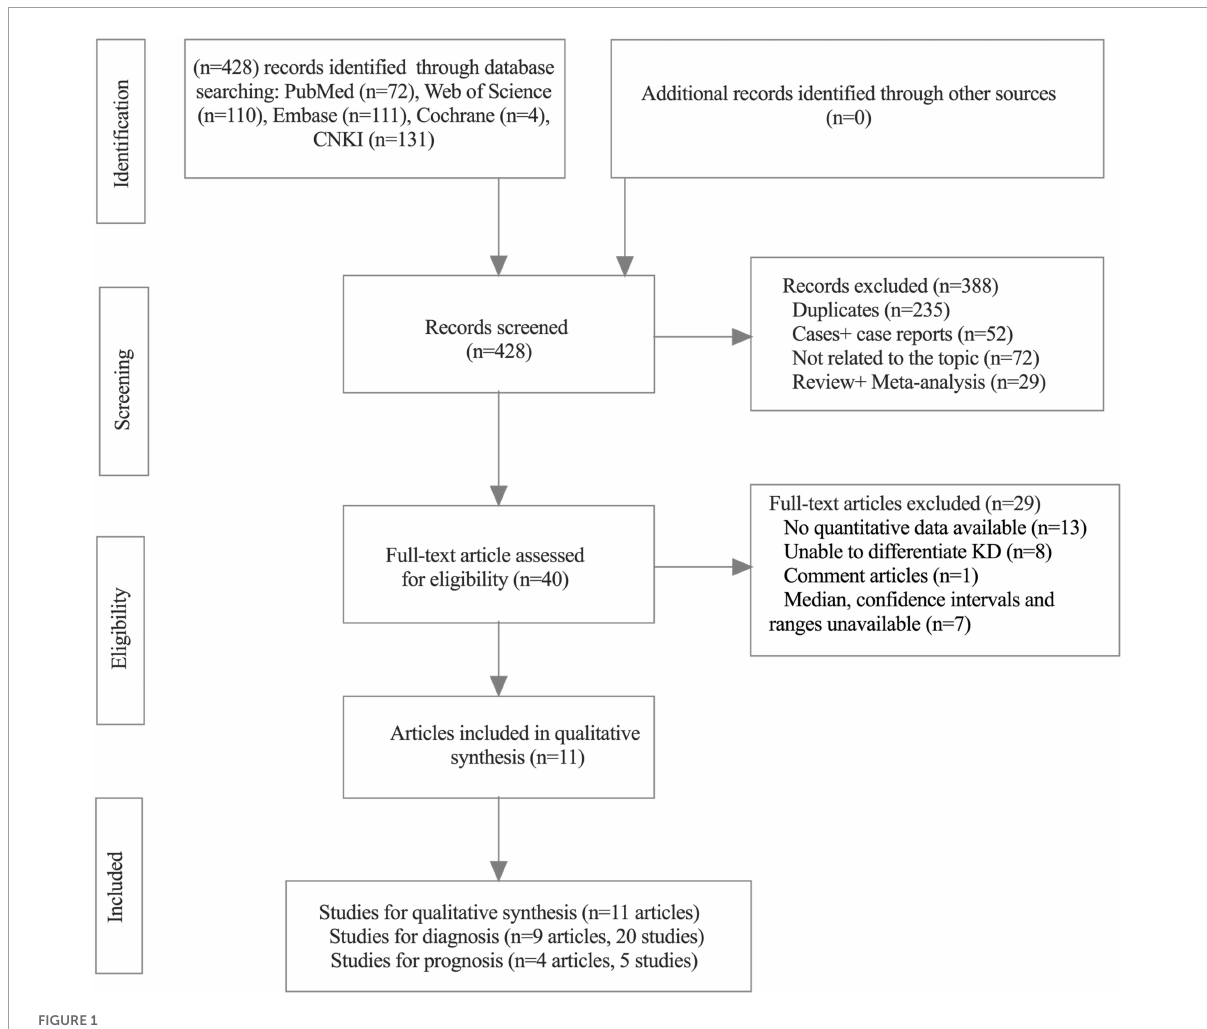
FIGURE1 Flow diagram of study selection